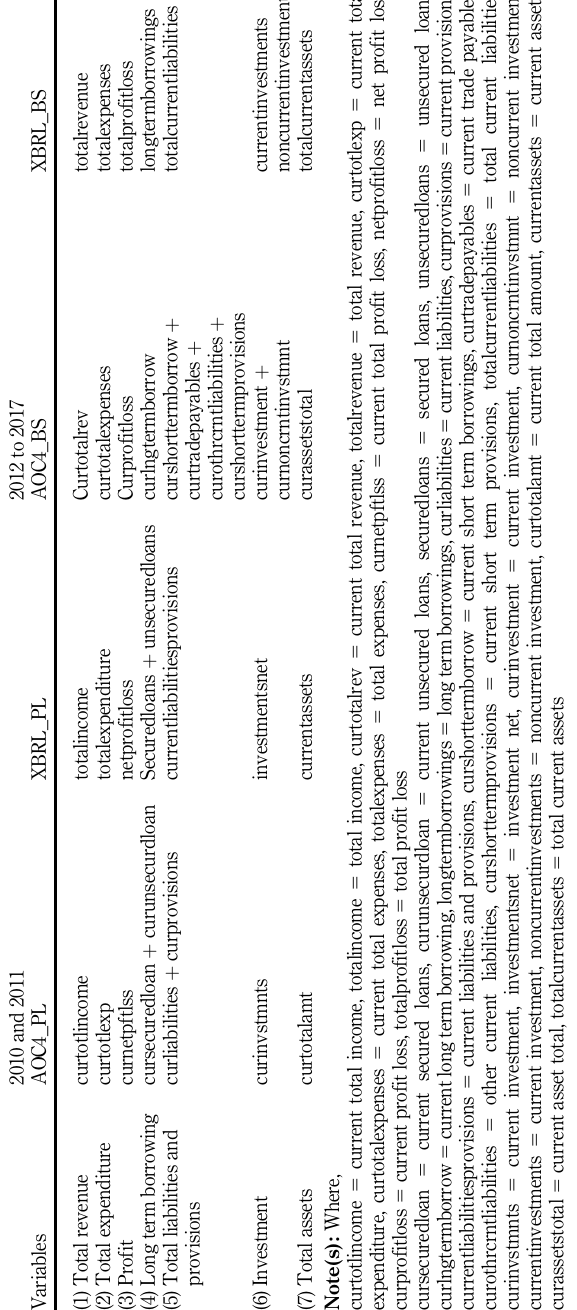
Table A1. Definition of